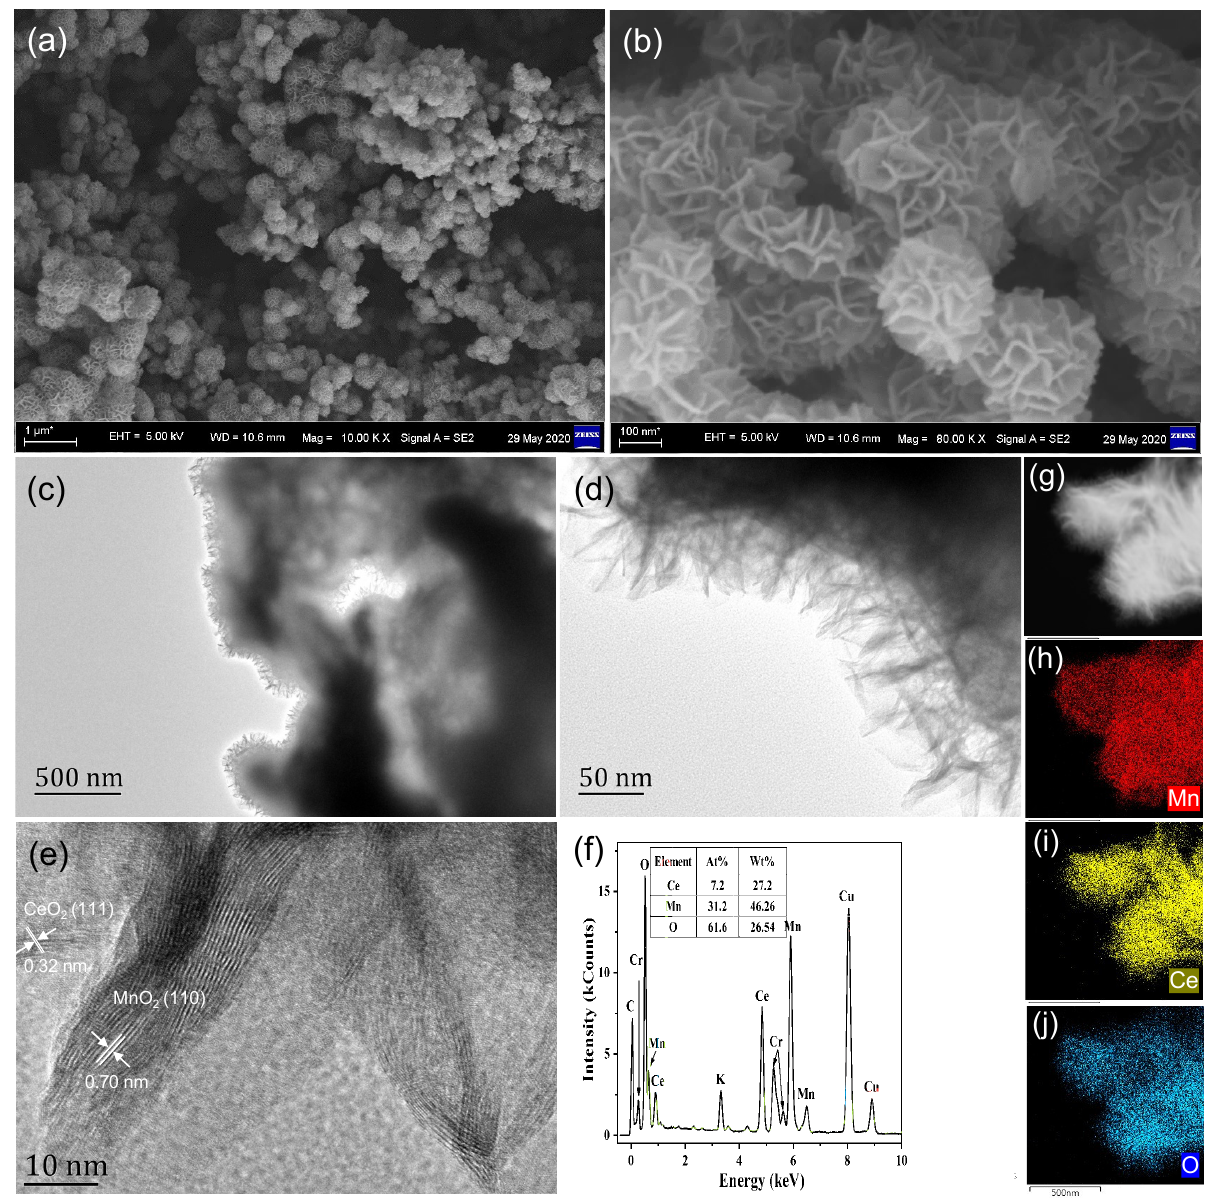
Figure 1. ( a) and ( b ) SEM, ( c ) and ( d ) TEM, ( c ) HRTEM, ( f ) EDS spectrum, ( g ) HAADF-STEM, and Figure 1. ( a , b ) SEM, ( c ) and ( d ) TEM, ( e ) HRTEM, ( f ) EDS spectrum, ( g ) HAADF-STEM, and ( h – j ) mapping images of Ce/Mn-3 ( h – j ) mapping images of Ce/Mn-3 (300).